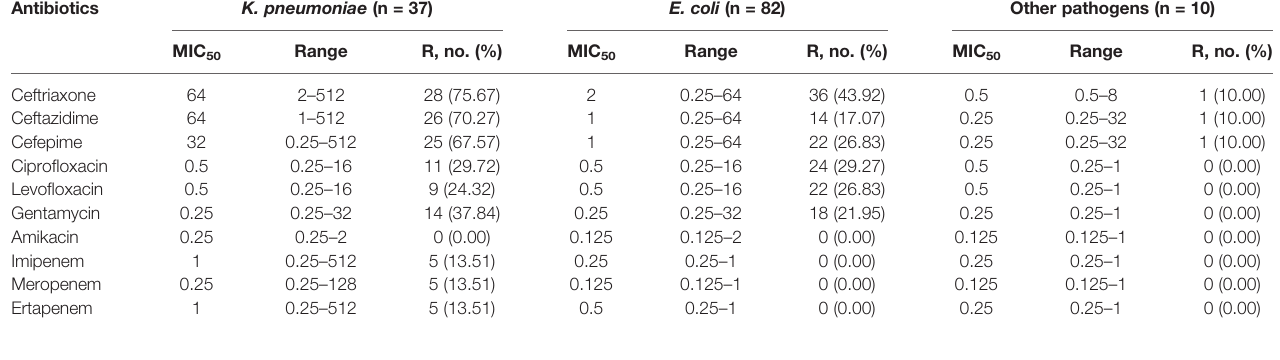
TABLE 2 | Antimicrobial susceptibility of Gram-negative bacteria isolates from neonate. Antibiotics K. pneumoniae (n =